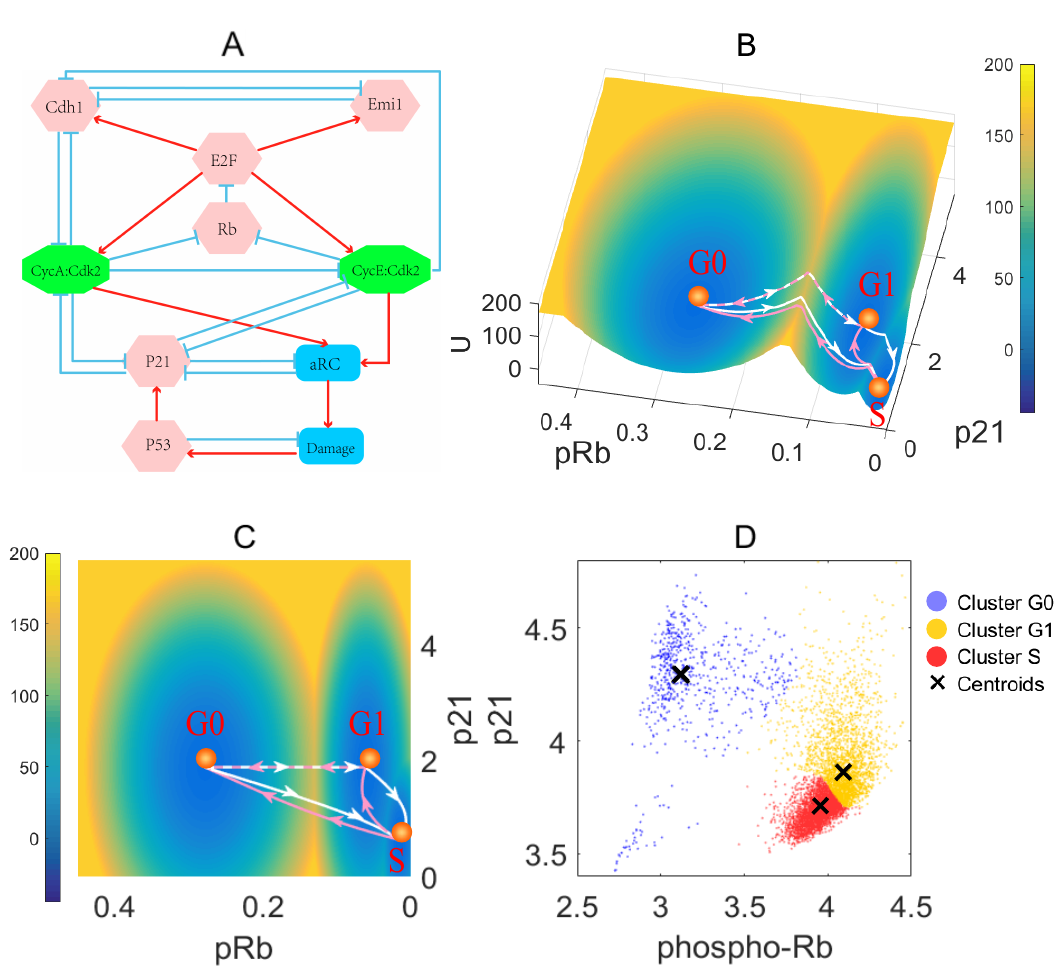
Figure 1. ( A ) The influence diagram of an early cell-cycle model. The red arrows represent activation and the blue bars represent inhibition. Pink hexagons represent transcription factors, green octagons represent protein complexes, and blue quadrilaterals represent cellular components of non-simple structures, including cell damage and cell replication-activated complexes. ( B ) The landscape of the proliferation–quiescence fate decision and transition path in 3D view. The white arrows represent the direction in which the cell cycle proceeds, and the pink arrows represents the backward direction of the cell cycle. The pRb axis represents the relative concentration of pRb, and the p21 axis represents the relative concentration of p21 (unit: AU). The U axis represents the potential energy. The G0 state represents the cell cycle cannot pass the RP and enters the G0 phase. The G1 state represents that the cell cannot pass the G1/S checkpoint and thus halt in G1. The S state represents that the cell cycle proceeds to the replication stage. The transition path represents the most probable path for